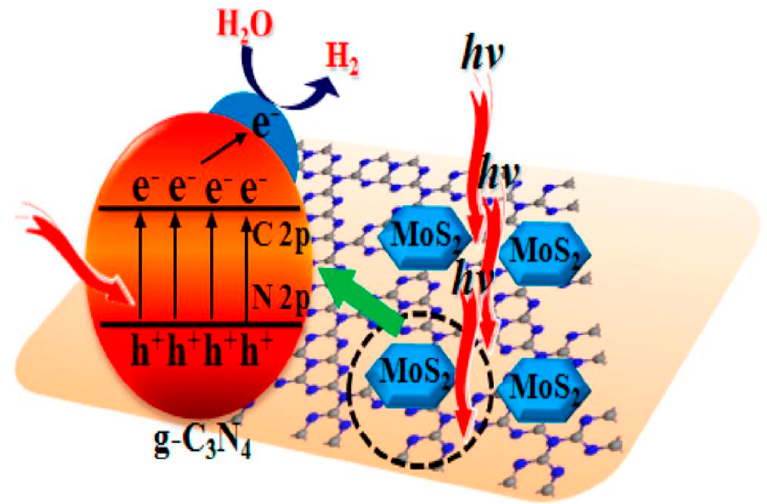
Figure 7. Schematic display of charge transfer on MoS 2 /g-C 3 N 4 heterostructures during water splitting. Reproduced with permission from Reference [72]; copyright (2014), American Chemical Society.